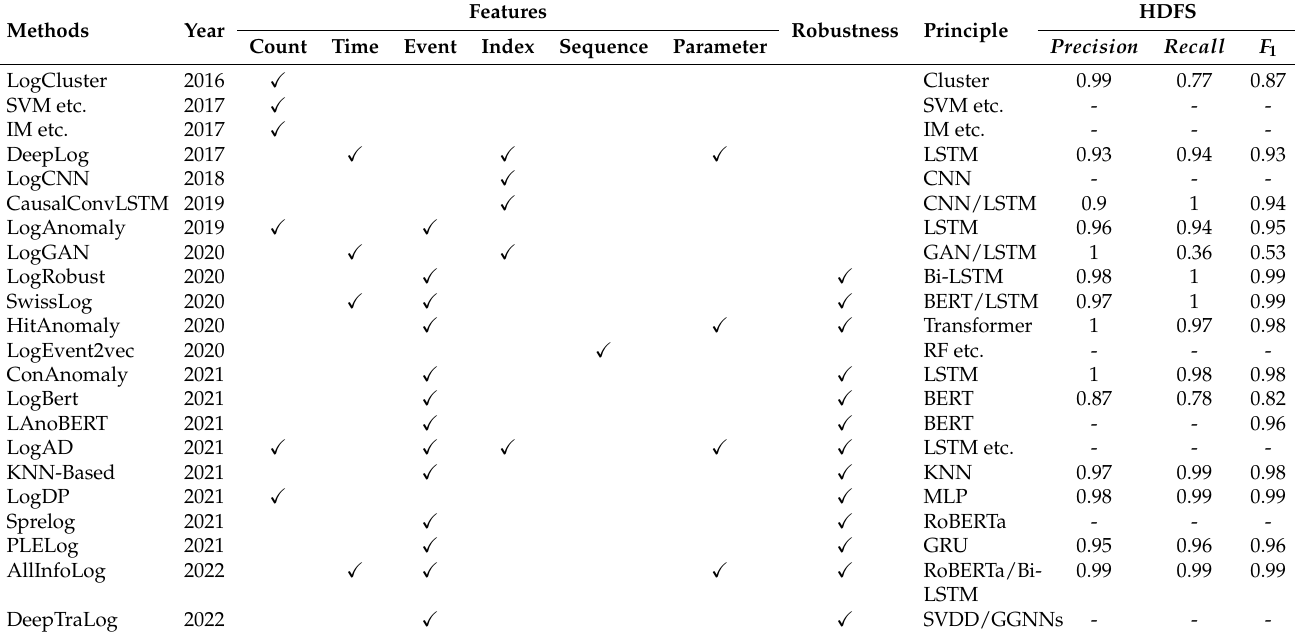
Table 3. Feature utilization, robustness, and effect comparison of log anomaly detection